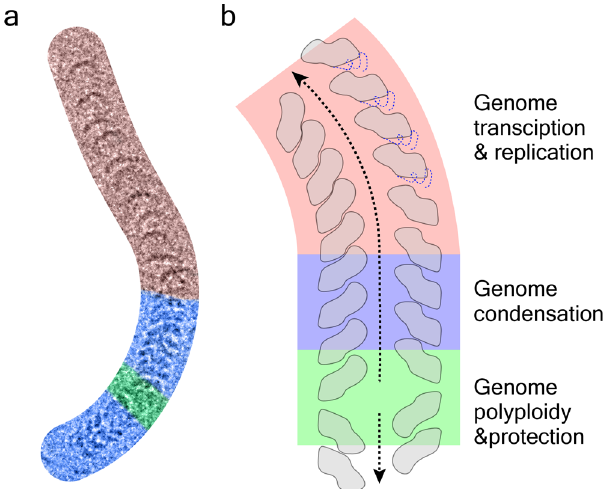
Fig. 5 A model illustrating the hypothesized distinct functions of different assembly forms. a Clam-shaped structure (light green), helical stems (light blue), and loosed coiled fi lament (light red) in one SeV nucleocapsid are highlighted. b A model illustrating the proposed distinct functions of different assembly forms. The same color strategy is used as in a